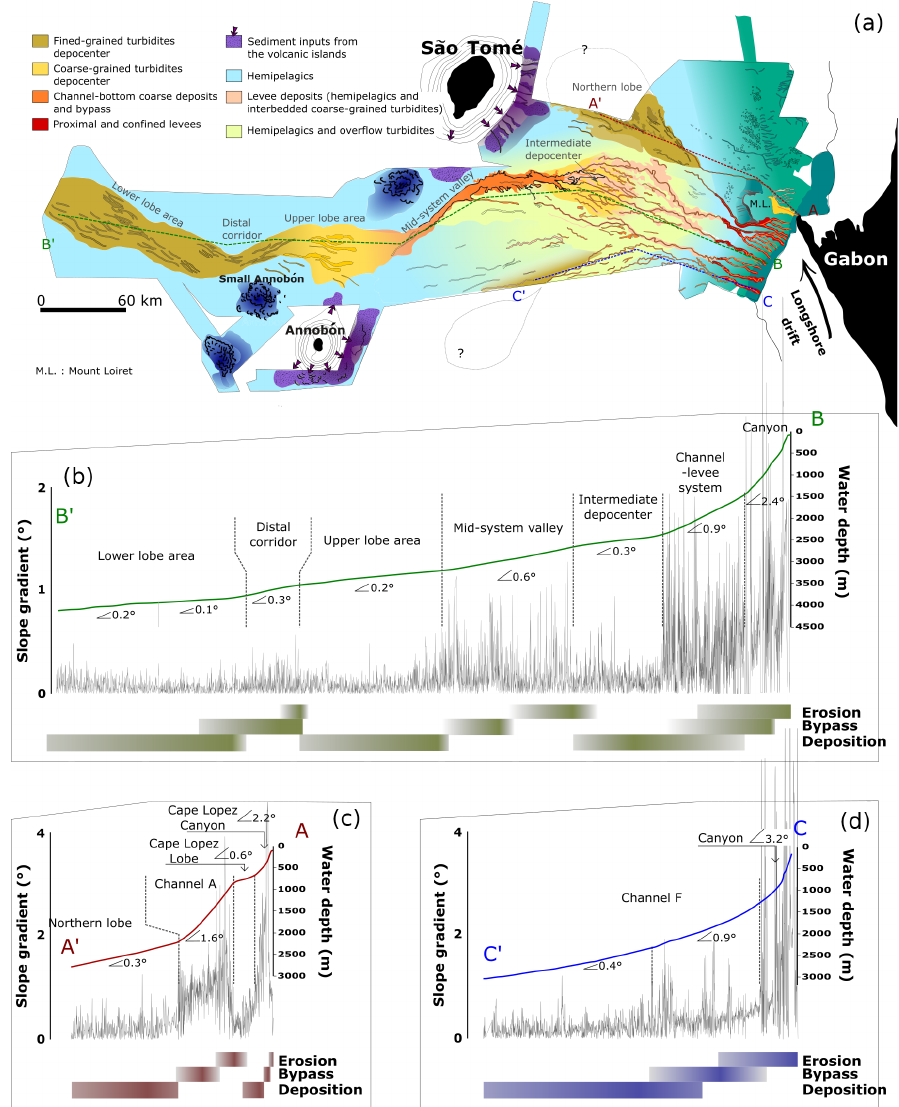
Figure 13. (a) Synthetic map showing the architecture and the recent sedimentary processes of the Ogooue Fan determined by imagery and echofacies mapping. (b, c, d) Longitudinal profiles from the bathymetric data along the central, northern and southern part of the Ogooue Fan and slope gradient (in degree, measured every 100m). The differences in slope gradient along the transects are associated with the main sedimentary processes encountered along the